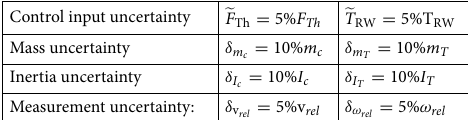
Table 6. Uncertainty amounts.